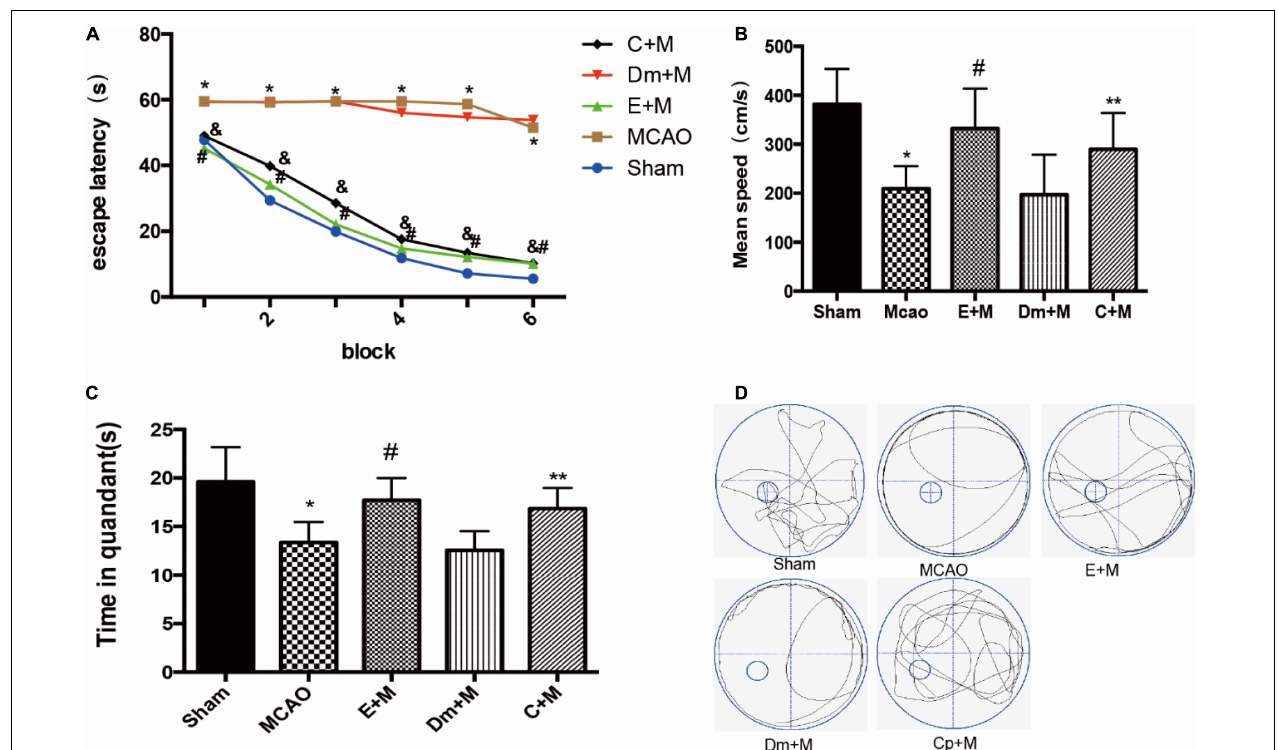
FIGURE 2 | Effects of electroacupuncture (EA) on cognitive function,as assessed using the Morris water maze (MWM) test at 24 h after reperfusion( n = 6). (A) Changes in the escape latency (i.e., the time required to locate and climb onto the platform) during six-block acquisition trials. EA pretreatment and administration of CCPA decreases the escape latencies in all trials; (B,C) effects of EA pretreatment and administration of CCPA on (B) mean speed and (C) time in quadrant. (D) The swimming tracks of rats in different conditions in the probe trial test. * P < 0.01 vs. the sham group, # P < 0.05 vs. the MCAO group, ** P < 0.05 vs. the MCAO group, & P < 0.05 vs. the MCAO